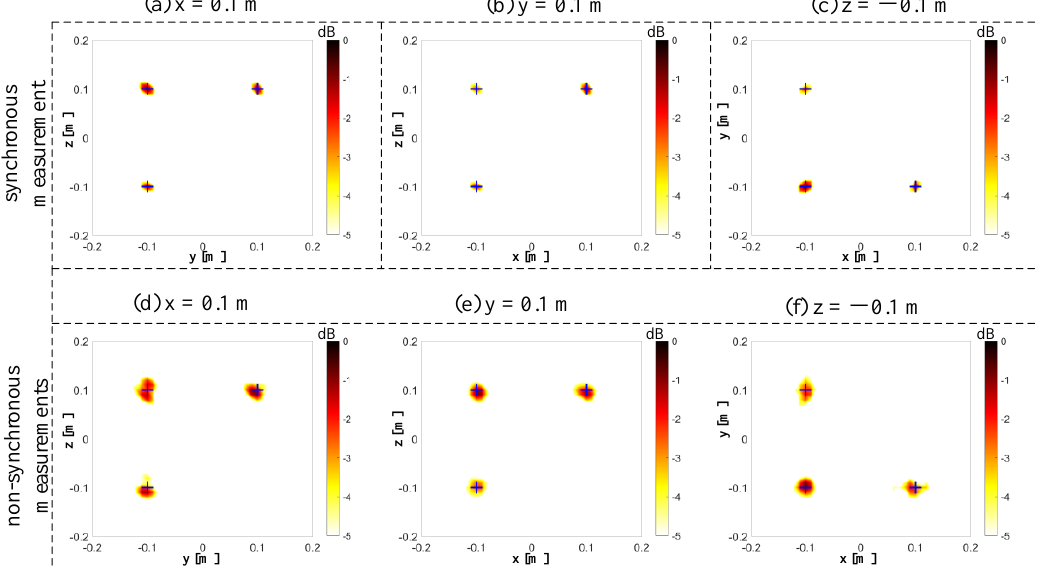
Figure 14. The beamforming results of the synchronous and non-synchronous measurements at 8000 Hz. ( a ) The beamforming map of the synchronous measurement at the x = 0.1 m slice. ( b ) The beamforming map of the synchronous measurement at the y = 0.1 m slice. ( c ) The beamforming map of the synchronous measurement at the z = −0.1 m slice. ( d ) The beamforming map of the non-synchronous measurements at the x = 0.1 m slice. ( e ) The beamforming map of the non-synchronous measurements at the y = 0.1 m slice. ( f ) The beamforming map of the non-synchronous measurements at the z = − 0.1 m slice.